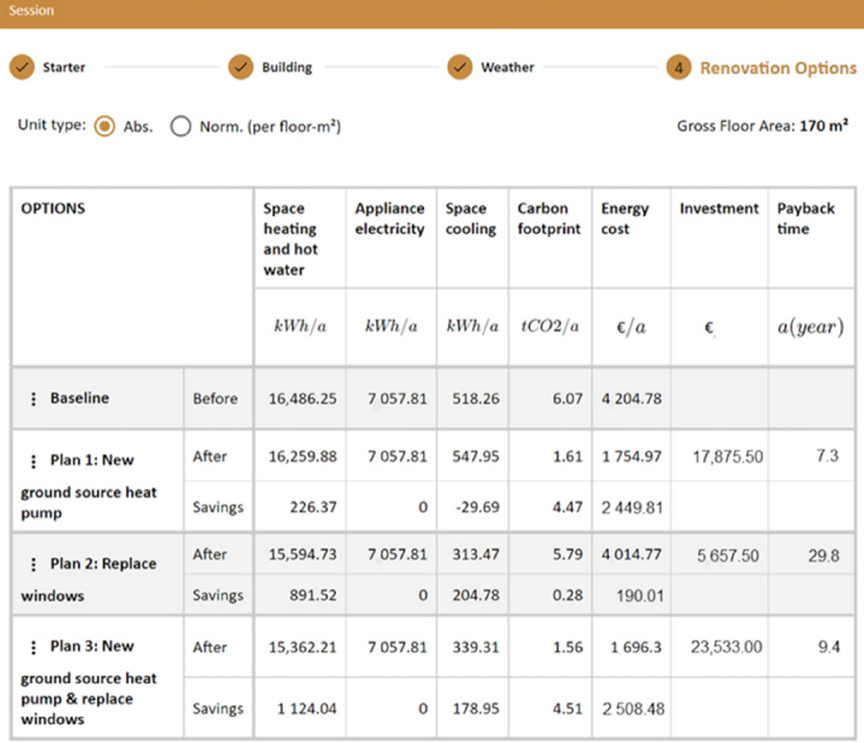
Figure 8. Retrofitting tool GUI: Results.